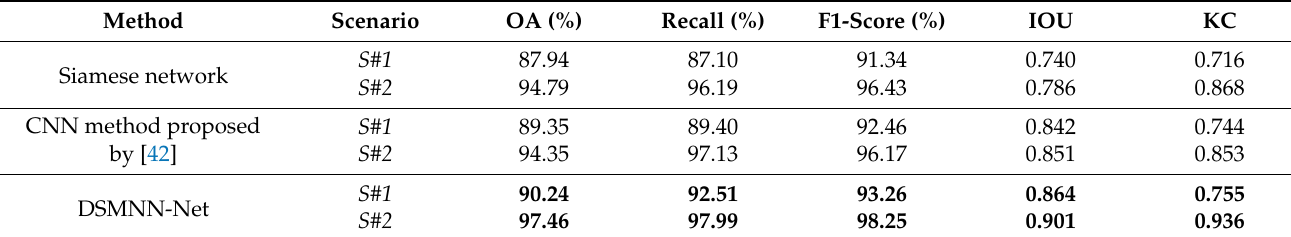
Table 4. Accuracy assessment for the burned area mapping for the first study area. S#1, pre/post- event Sentinel-2 imagery; S#2, pre-event Sentinel-2 imagery and post-event PRISMA imagery.